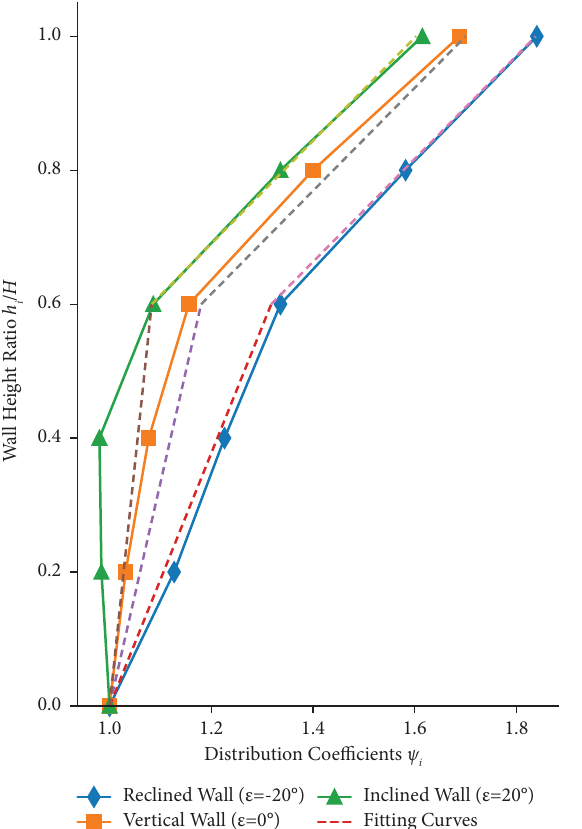
Figure 9: Fitting curves of the distribution coefcient ψ